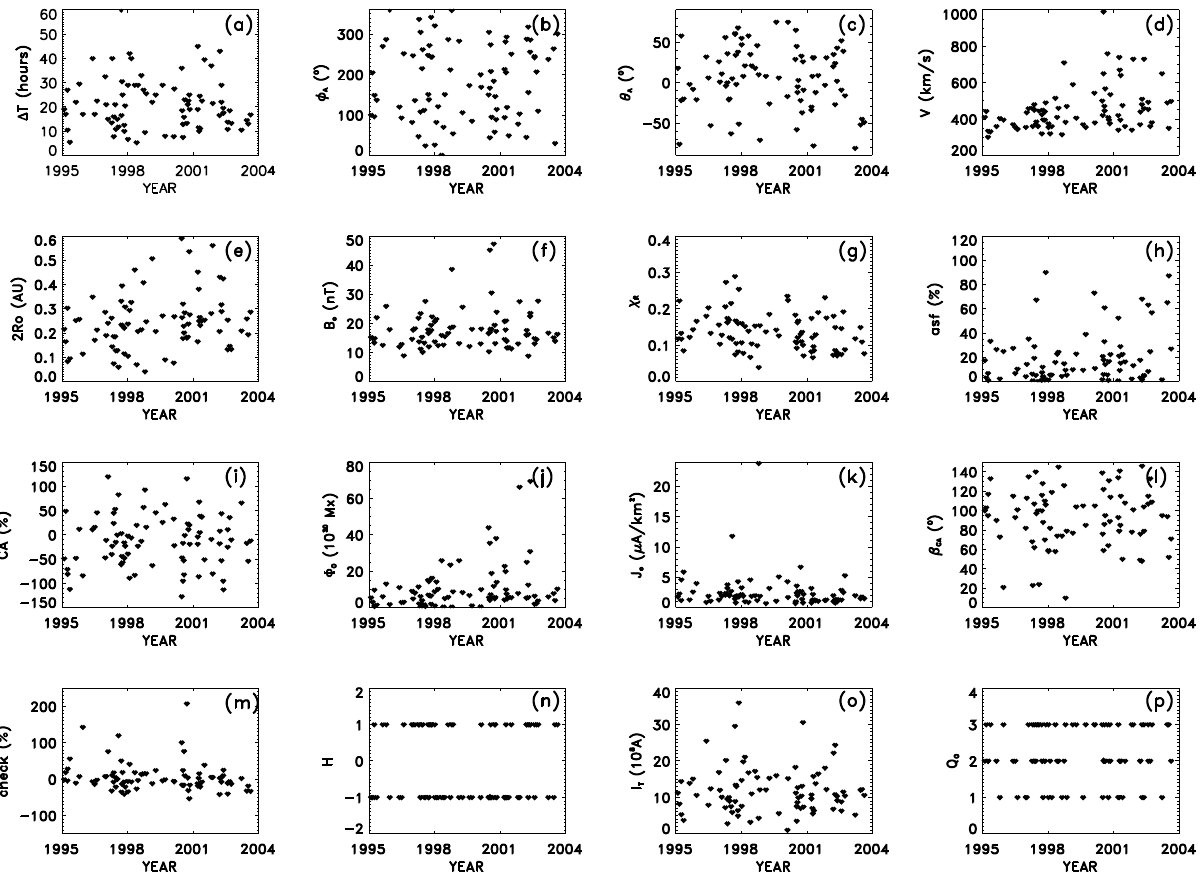
Fig. 11. Variation of various MC quantities vs. time for all 82 cases; the quantities match those of Fig. 10, except for the last three, where the histograms in Fig. 10 of < B X > Cl , < B Y > Cl , and < B Z > Cl , respectively, are now replaced by: (n) handedness [H]; (o) total axial current [I T ]; and (p) quality [Q 0